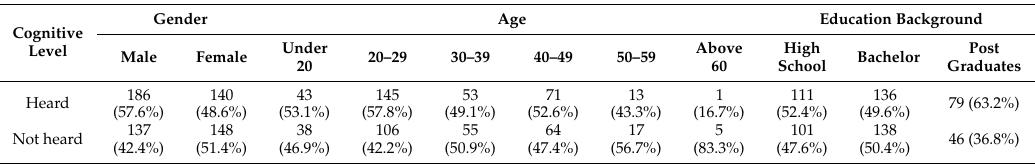
Table 2. Cognitive level of remanufactured products.